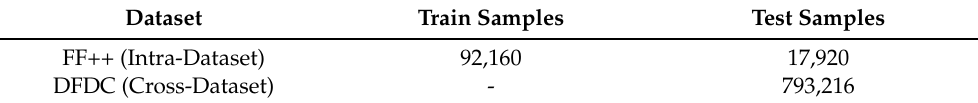
Table 1. Number of samples (frames) adopted for the training and testing